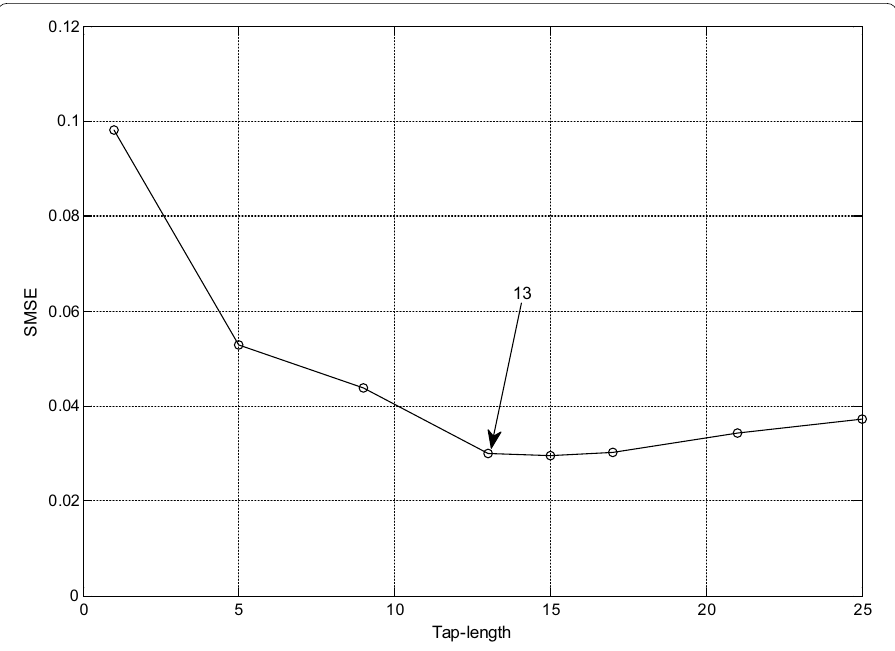
Fig. 2 SMSE performance under different tap-length